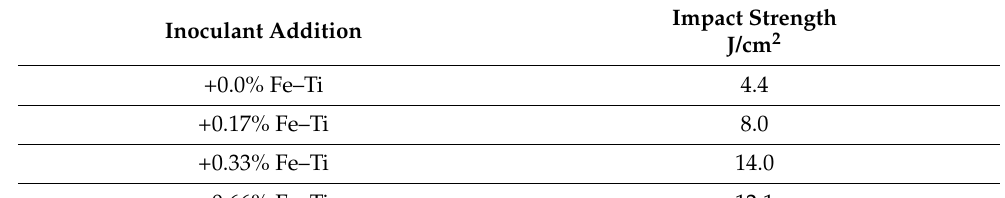
Table 3. Impact strength of the tested cast iron samples.